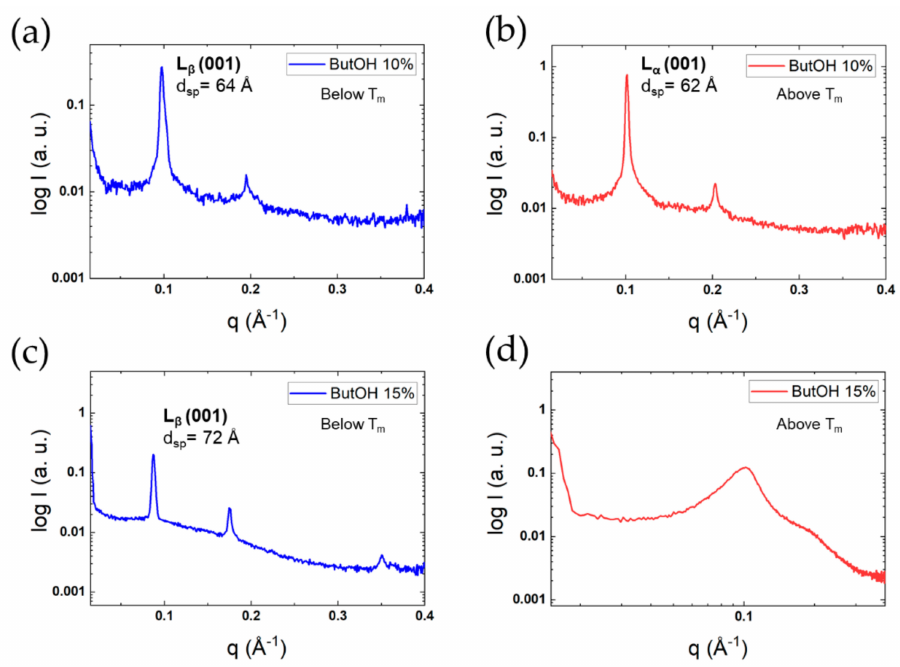
Figure 11. SAXS patterns for DODAC in the presence of butanol. Top panels: 10.0 wt% of the additive: ( a ) below the T m , and ( b ) above the T m . Bottom panels: 15.0 wt% of the addi- tive: ( c ) below the T m (10 ◦ C) and ( d ) above the T m